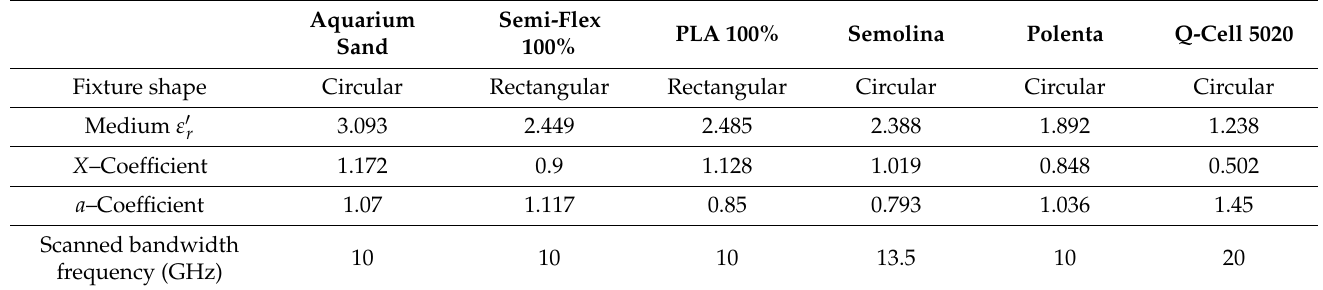
Figure 10. Relative permittivity and loss tangent of the PLA measured with the circular coaxial fixture. For the same test cell (circular coaxial), it can be seen that the relative permittivity and the correction coefficient X increased. However, at the same time, the a –coefficient decreased. As a consequence, it is observed in Table 1 that the correction coefficient X depends on the scanned frequency (in terms of the bandwidth and the considered number of points), the test cell, and its shape. Table 1. Comparison values of ε (cid:48) r , X , and a according to the coaxial test cell